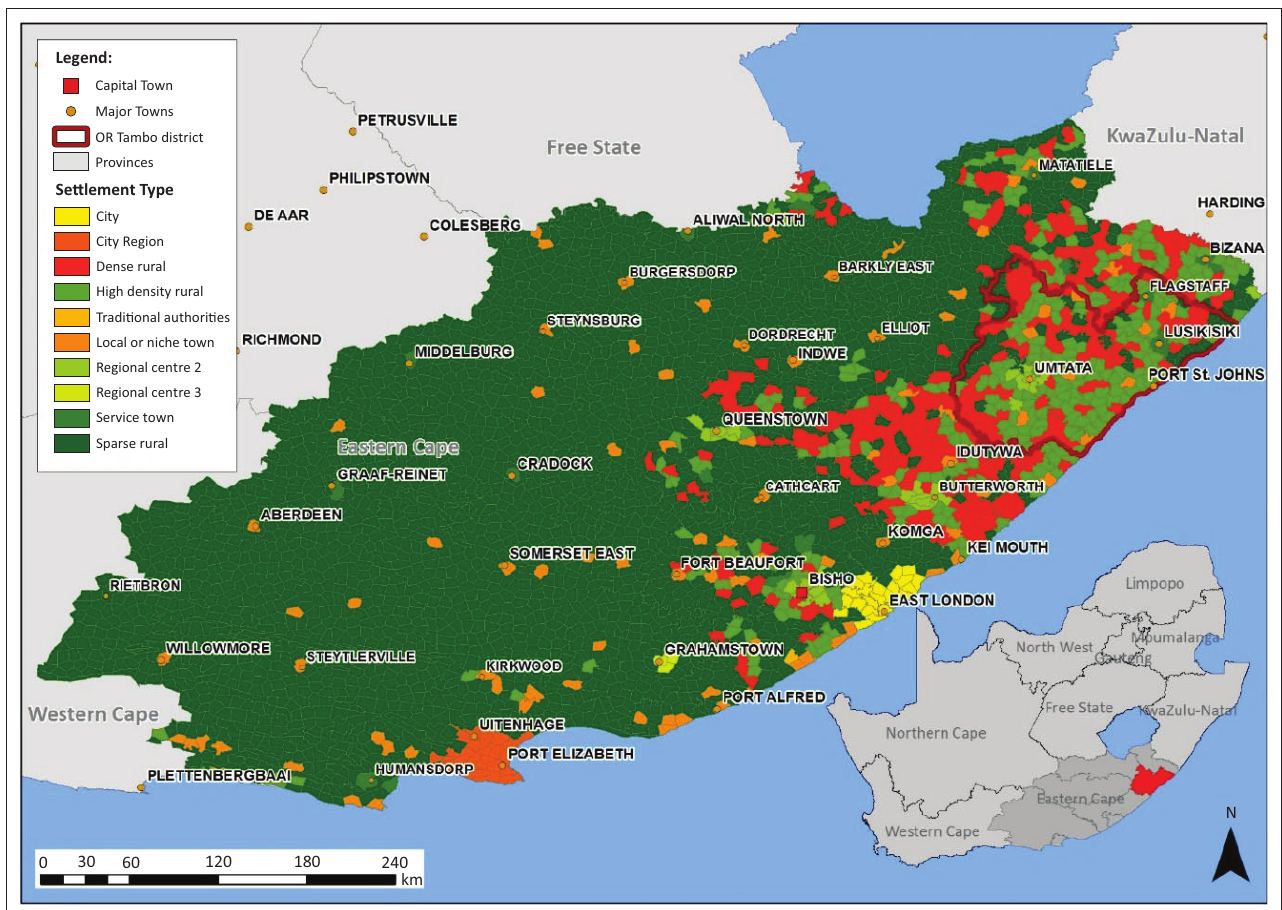
FIGURE 1: O.R. Tambo district in Eastern Cape